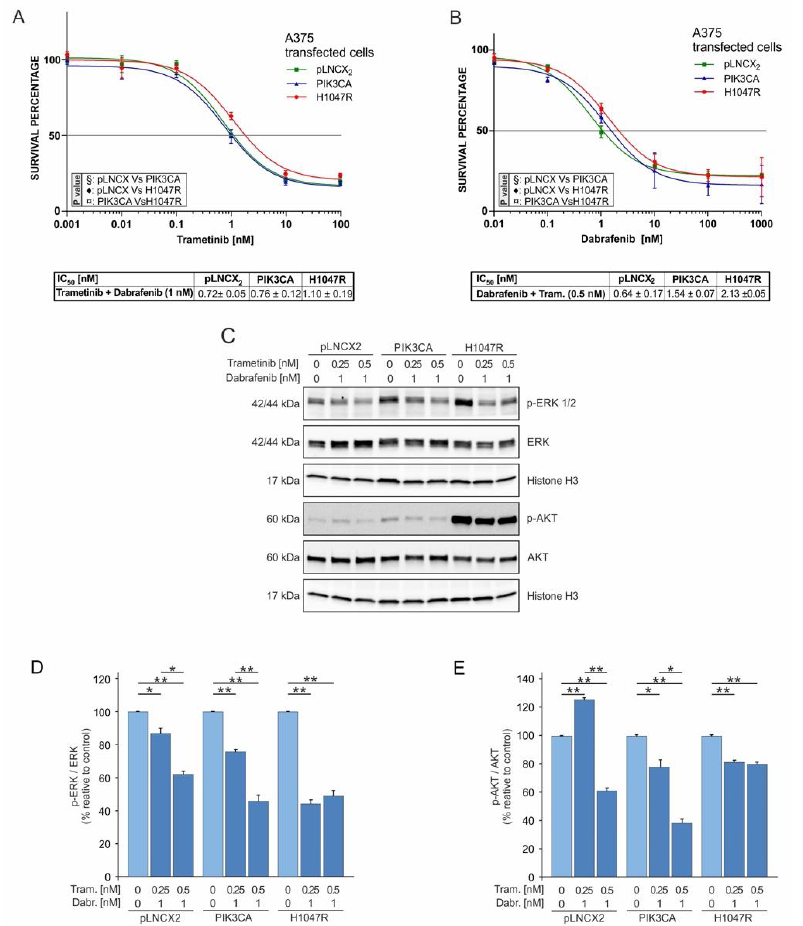
Figure 4. Combined dabrafenib and trametinib treatments of A375 transduced cells. ( A ) MTT